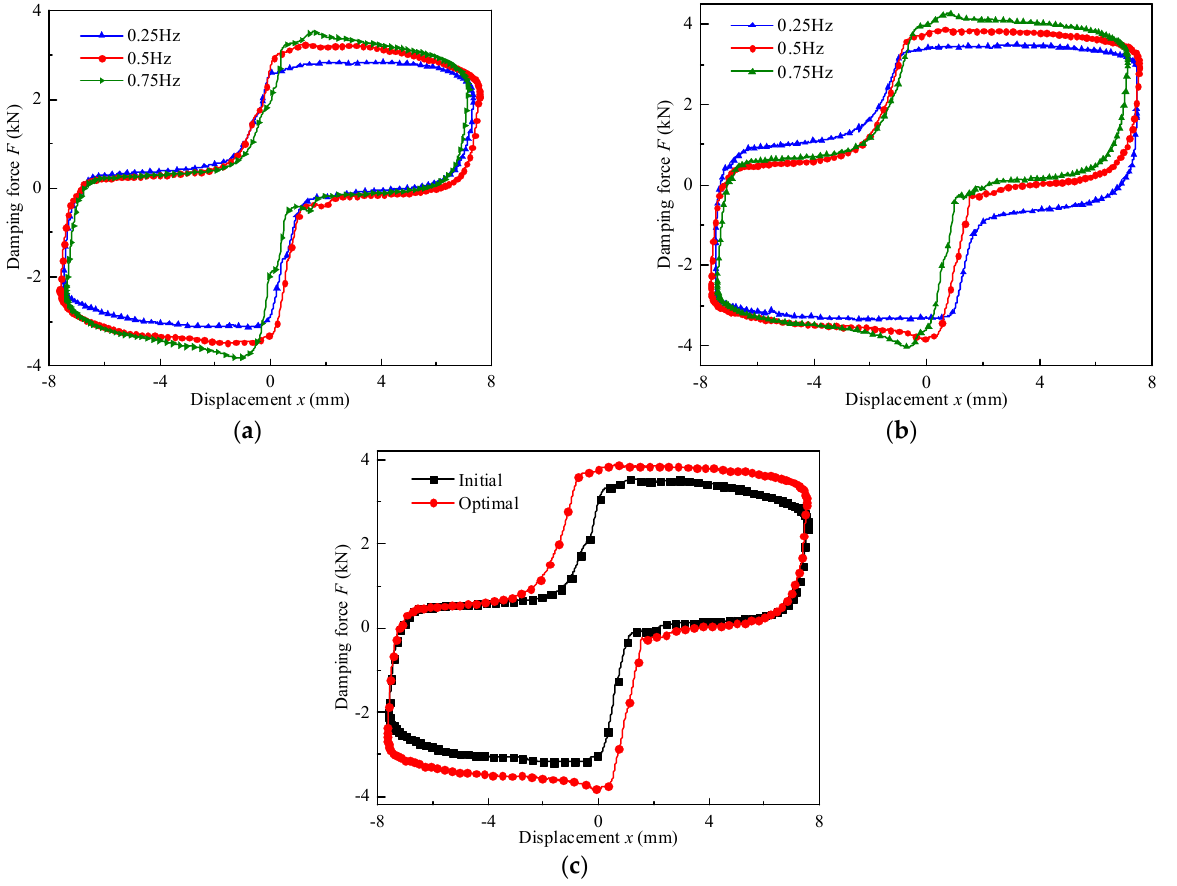
Figure 26. Damping force versus displacement at constant amplitude and current: ( a ) initial, ( b ) optimal, (c) comparison of the initial and optimal damping force.